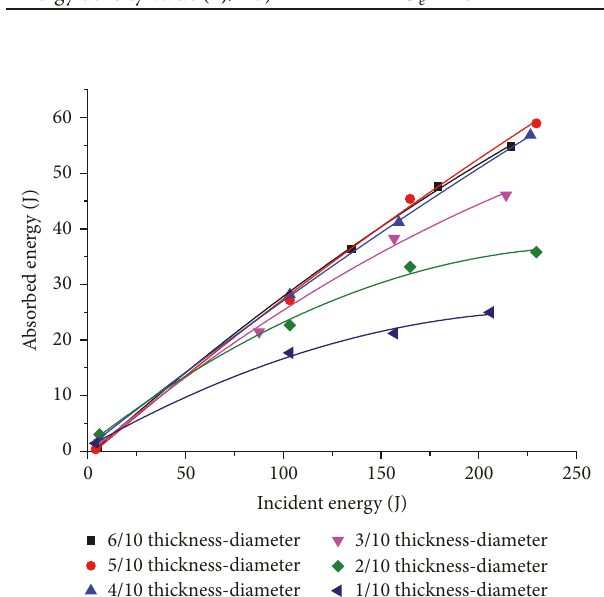
Figure 15: Curves between absorbed energy and incident energy under different thickness–diameter